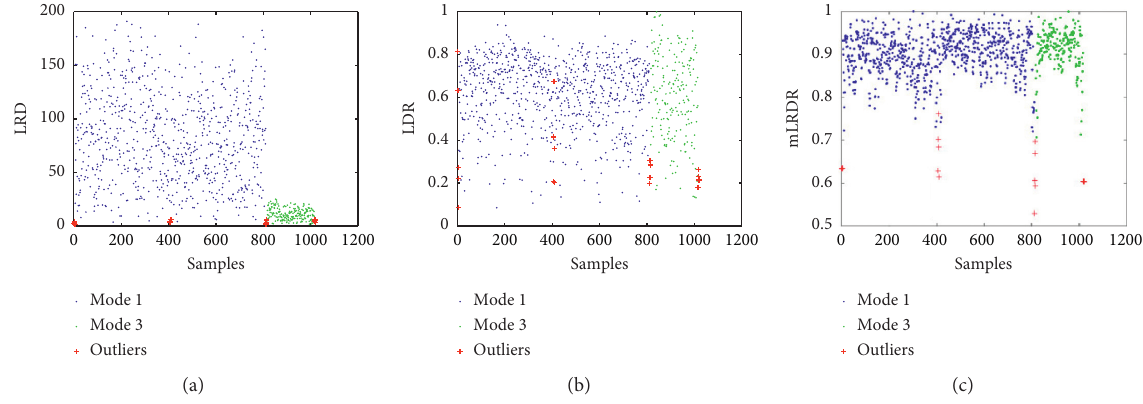
Figure 6: (a) LRD; the weight of each training data based on (b) LDR and (c)